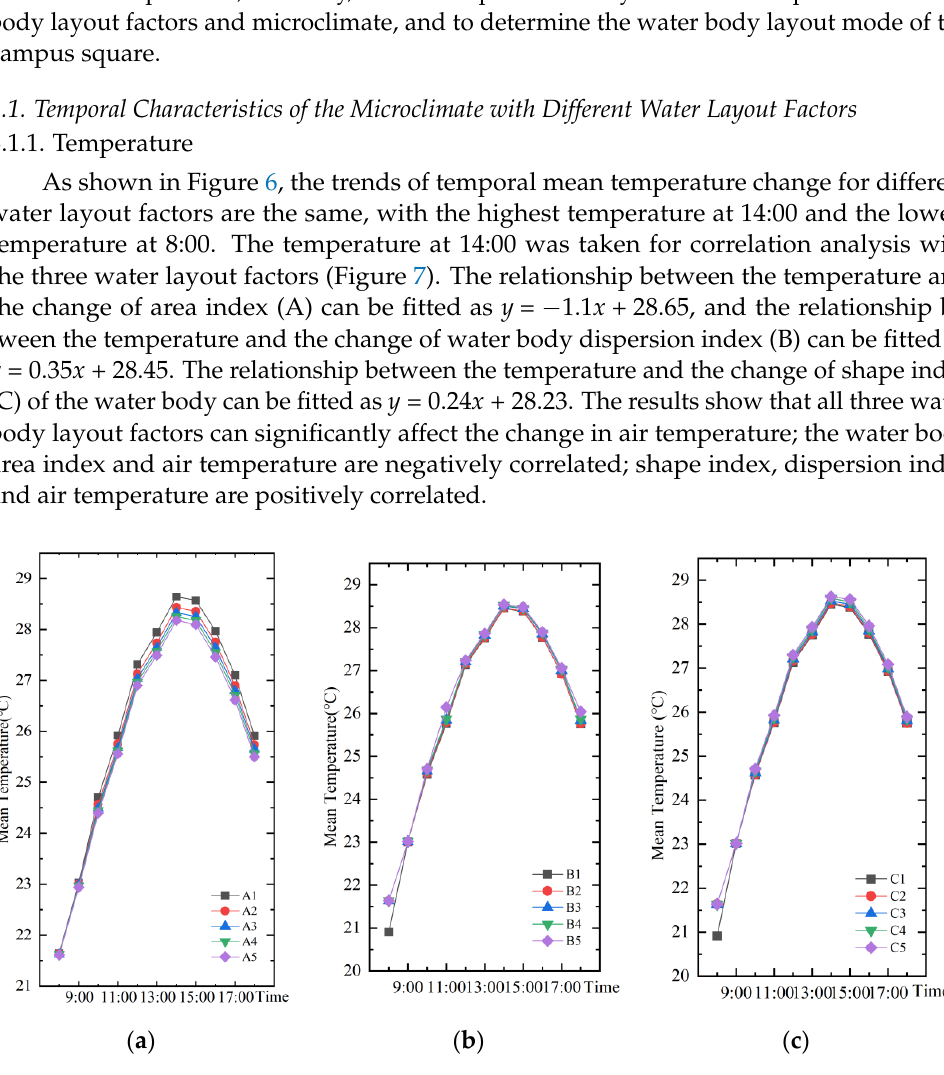
Figure 6. The trend of temporal mean temperature change for different water body layout factors: ( a ) Water body area index; ( b ) Water body dispersion index; ( c ) Water body shape